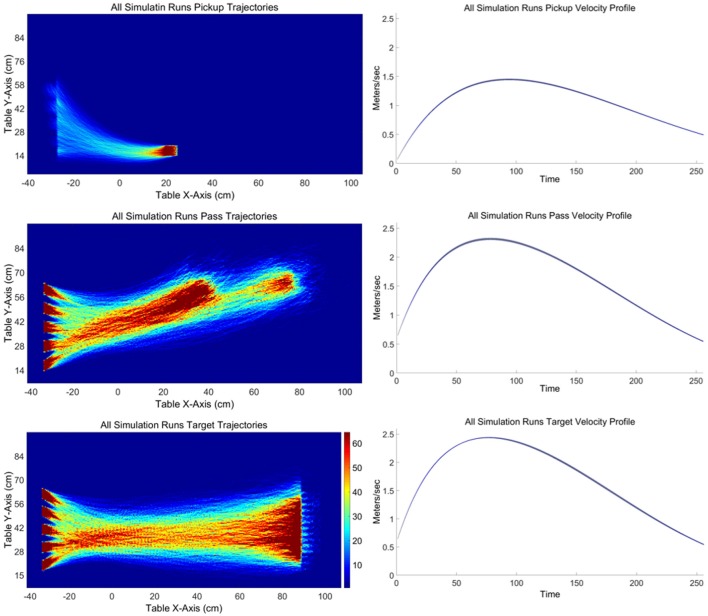
(Left) Heat maps illustrating all simulation run trajectories for the pickup (left top), pass (left middle), and target (left bottom) sub-task goal movements. (Right) Average simulation velocity profile for each sub-goal trajectory, ready-pickup (right top), pickup-pass (right bottom), and pickup-target (right bottom), in meters per second with 5% and 95% confidence intervals indicated in gray.